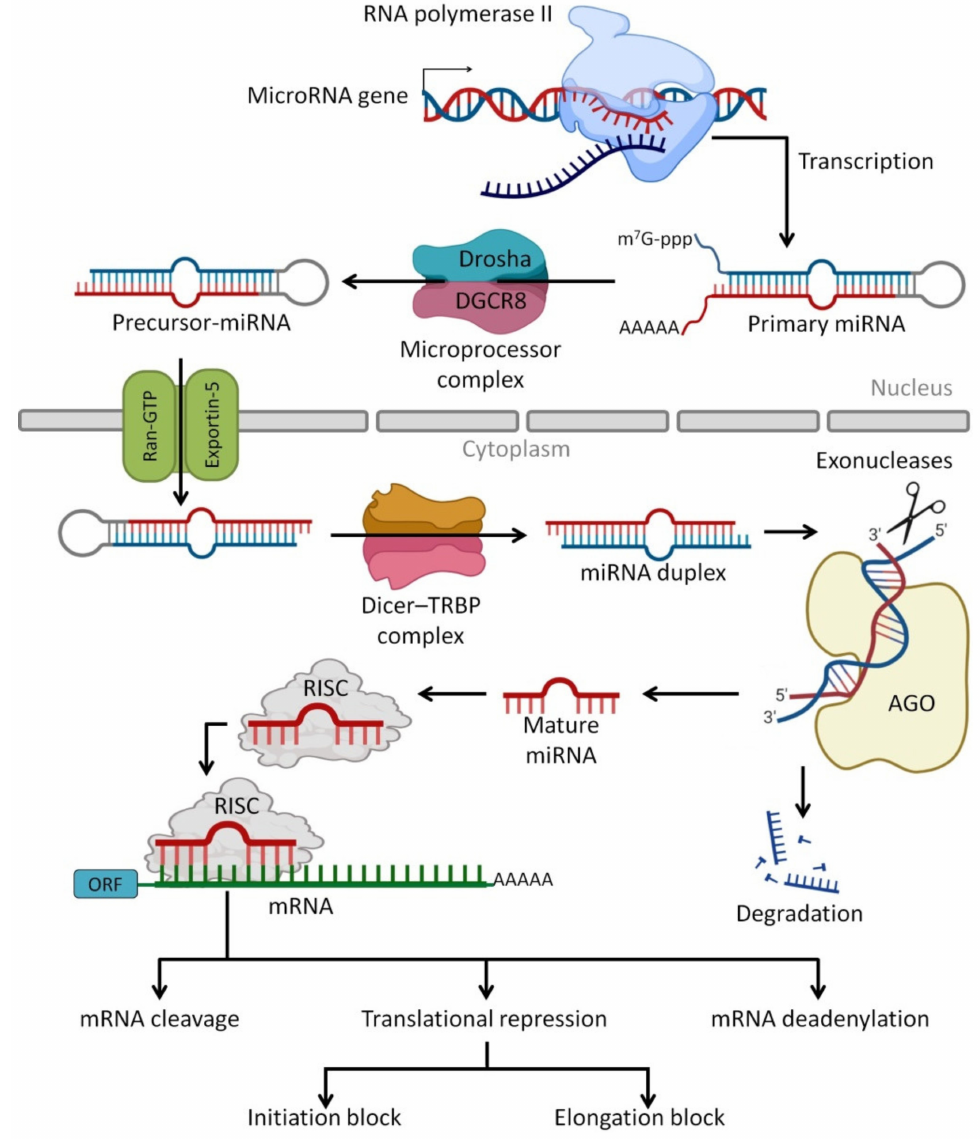
Figure 4. A scheme of miRNA biogenesis and processing pathways. The process starts when RNA polymerase II transcribes the targeted miRNA from DNA sequences into a primary miRNA